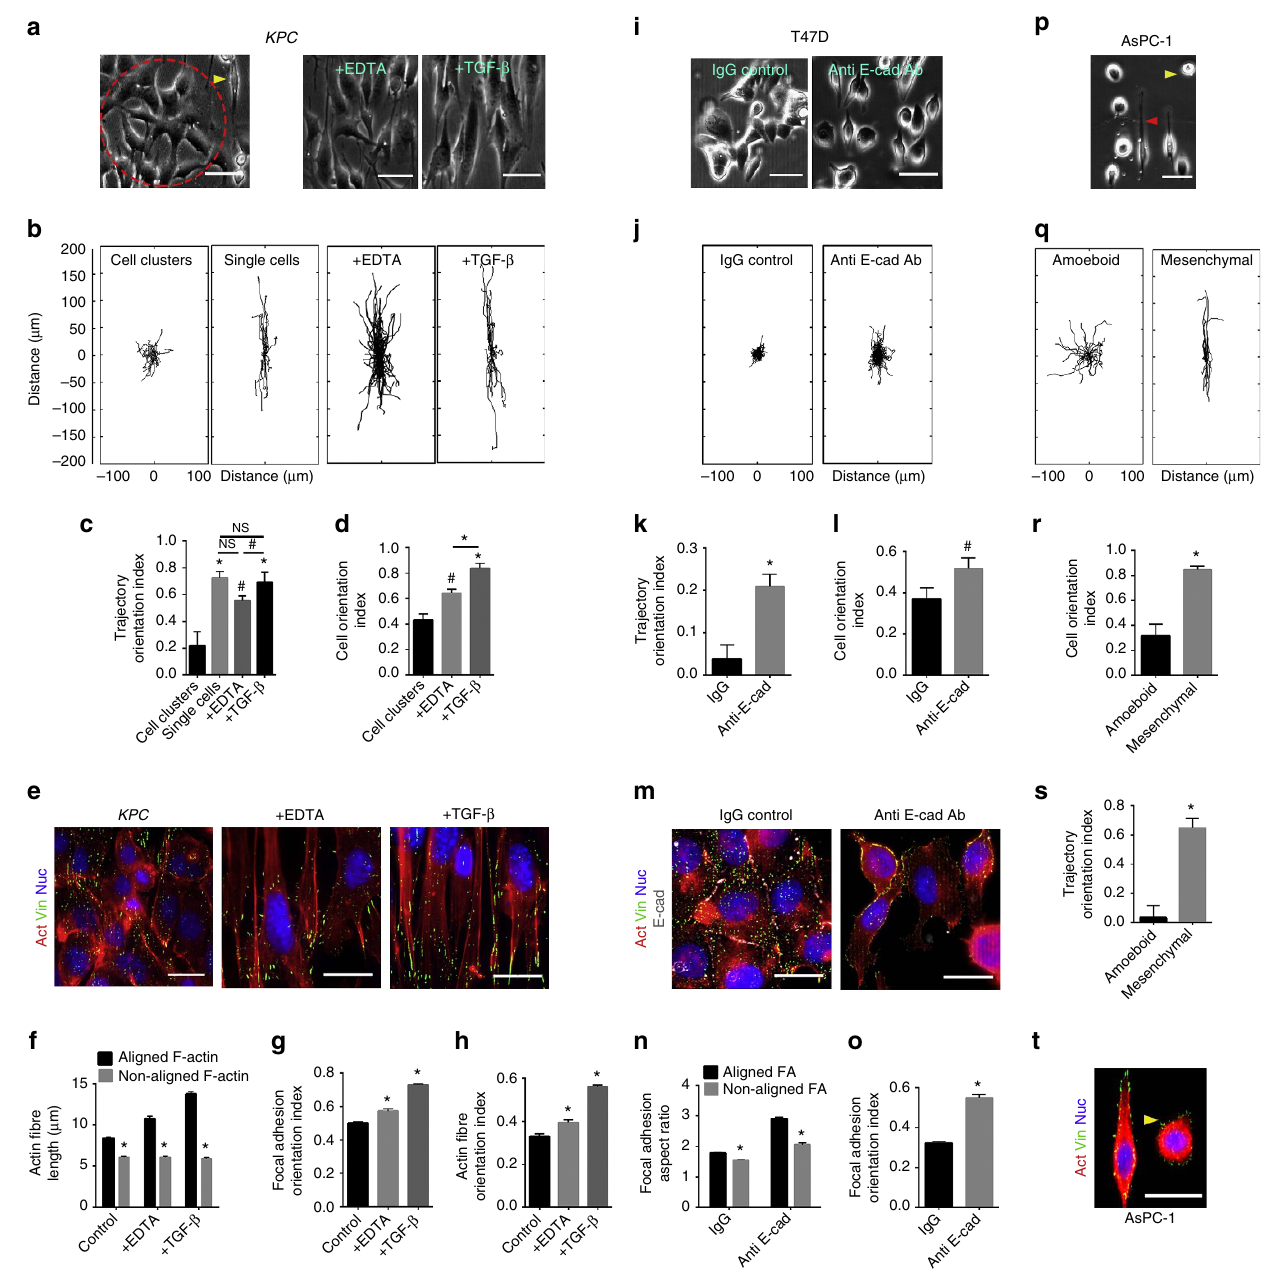
Figure 7 | Cell–cell interactions or the amoeboid migration mode diminish directional guidance from nanopatterned cues. ( a ) Phase contrast images of KPC cells on patterned substrates show aligned single cells (yellow arrowhead) and randomly oriented clustered cells (red circle), while KPC cells treated with 2mM EDTA or TGF- b switched to the single-cell phenotype ( b ) Trajectory maps of cells in clusters, single cells and those treated with EDTA and TGF- b . ( c , d ) Trajectory ( c ) and cell ( d ) orientation indices of the groups in a , b . ( n ¼ 30–115 per group, symbols on top of columns represent comparison with the cell cluster group). ( e ) Fluorescence micrographs of KPC cells engaged in cell–cell clusters, EDTA and TGF- b -treated KPC cells on nanopatterned substrates stained for F-actin (red), Vinculin (green) and nuclei (blue) showing distinct phenotypes for single versus collective cells. ( f ) Orientation-dependent F-actin length distribution is enhanced by inducing a single-cell or EMT phenotype ( n 4 1,000 per group), so are ( g ) focal adhesion ( n 4 400 per group) and ( h ) actin fibre alignment ( n 4 1,000 per group). ( i ) Phase contrast images of IgG control and 5 m M SHE787-treated T47D cells on aligned substrates showing clustered to single-cell phenotype shift. ( j ) Trajectory maps showing increased aligned migration in the SHE787-treated group. ( k , l ) Trajectory ( k ) and cell ( l ) orientation indices of the groups in i , j ( n 4 70 per group). ( m ) Fluorescence micrographs of IgG control and SHE787-treated T47D cells on nanopatterned substrates stained for F-actin (red), Vinculin (green), E-cadherin (grey) and nuclei (blue). ( n ) Orientation-dependent FA elongation is enhanced by disrupting cell–cell junctions ( n 4 300 per group), so is ( o ) focal adhesion alignment ( n 4 700 per group). ( p ) Representative phase contrast micrograph of AsPC-1 cells on an aligned substrate showing elongated mesenchymal-like (red arrowhead) and rounded, amoeboid-like cells (yellow arrowhead). ( q ) Migration trajectory maps of the two sub-groups. ( r , s ) Cell ( r ) and trajectory ( s ) orientation indices of the corresponding groups in p , q ( n 4 30 per group). ( t ) Fluorescence micrographs of AsPC-1 cells on nanopatterned substrates showing typical mesenchymal and amoeboid (yellow arrowhead) morphologies with staining for F-actin (red), Vinculin (green) and nuclei (blue). Scale bars, 20 m m. * P o 0.001, # P o 0.05, NS: no significance (Kruskal–Wallis test: c , d ; unpaired t -test: f , l , n , o ; ANOVA: g , h ; Mann–Whitney test: k , r , s